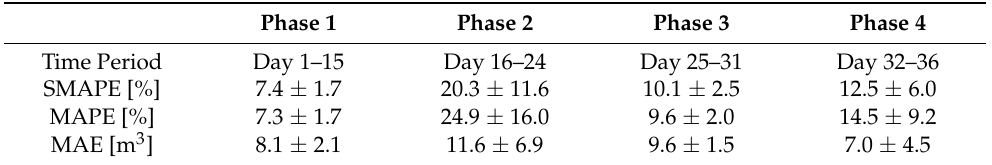
Table 1. Mean values of accuracy parameters SMAPE [%], MAPE [%], and MAE [m 3 ] to evaluate the quality of simulation